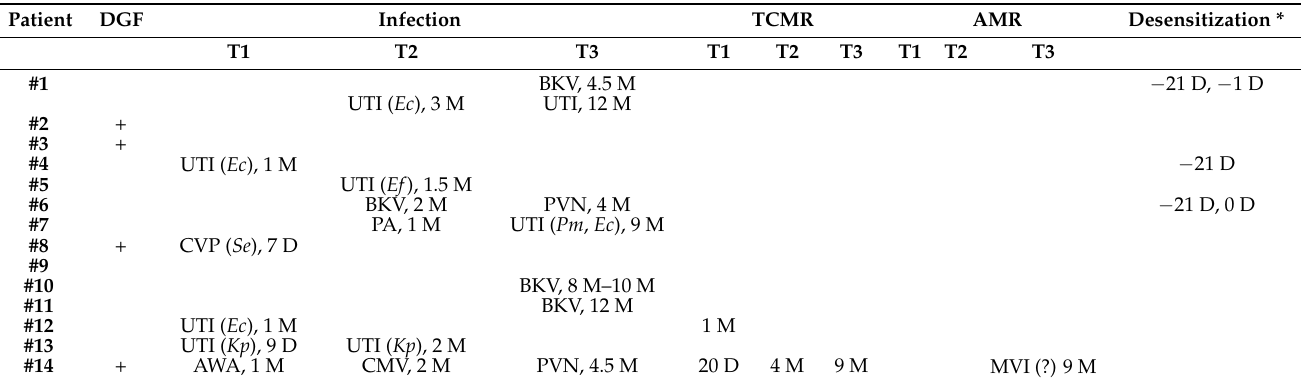
Table 2. The clinical events of all 14 renal transplant patients along the course of immunosuppressive